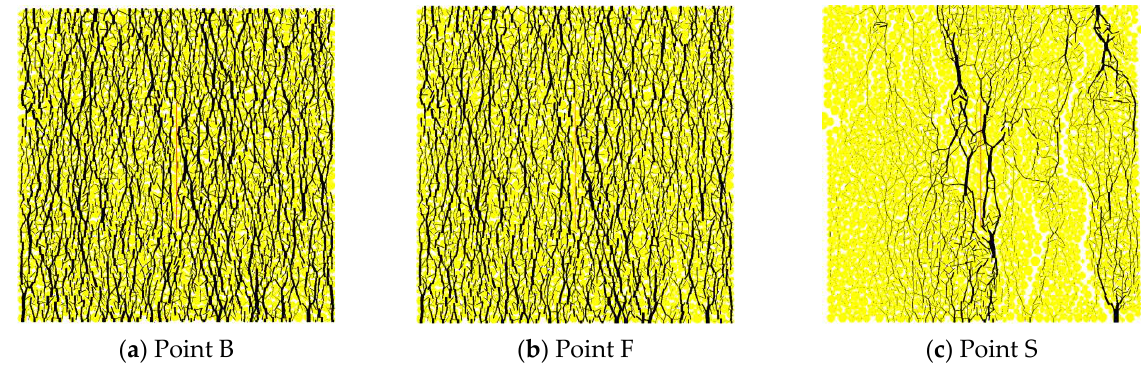
Figure 17. Evolution of the parameters of the joint system with increasing axial strain ( β = 90 ◦ ).